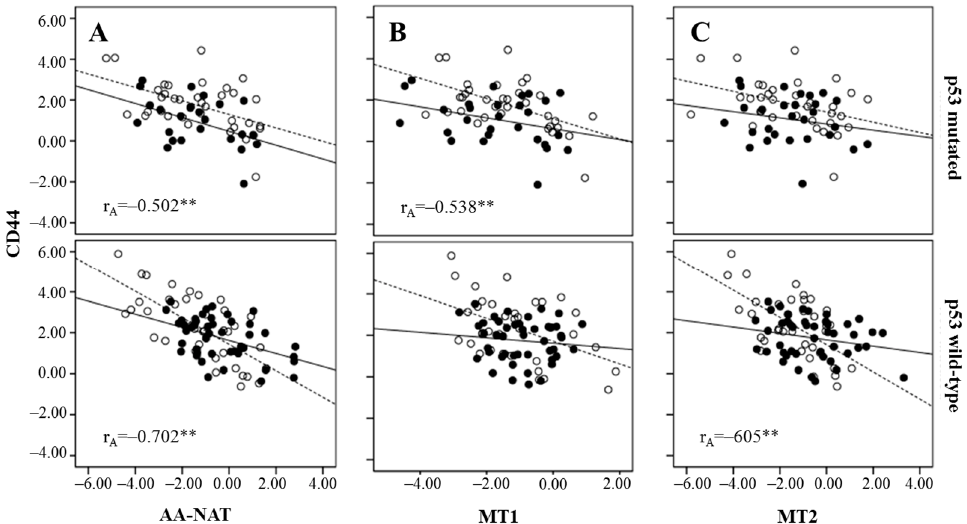
Figure 5. Correlation of CD44 expression and AA-NAT ( A ), MT1 ( B ), and MT2 ( C ) expression, stratifying by p53 status (wild-type or mutated) and in early stage tumors (—) and in advanced tumors ( . . . .). Pearson’s correlation coefficients: r A (advanced tumors). ** p < 0.01.